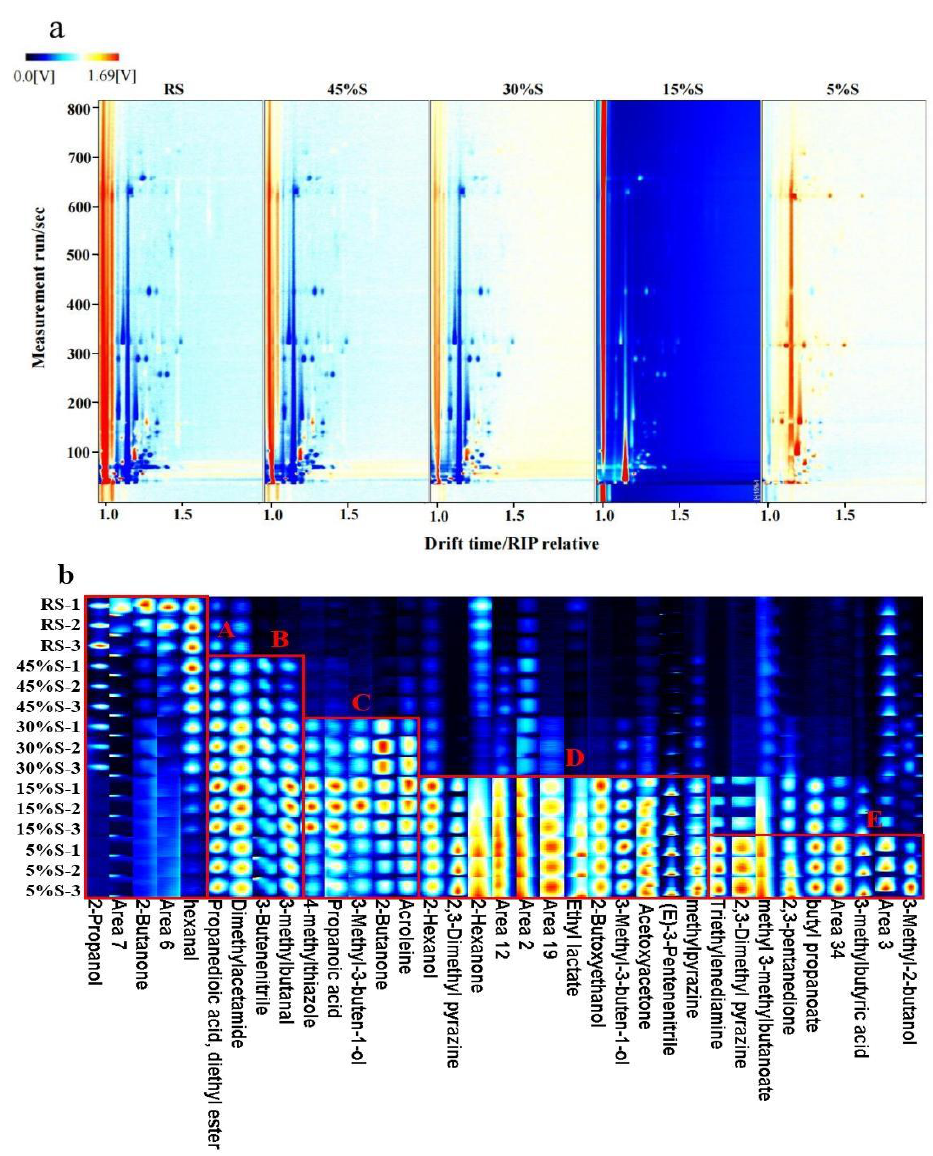
Figure 1. Difference comparison plots ( a ) and gallery plot ( b ) of volatile components of shrimp samples with different moisture contents (each column represents a compound, each row represents a sample, and the signal peak color represents the substance concentration, the darker the color, the greater the concentration).